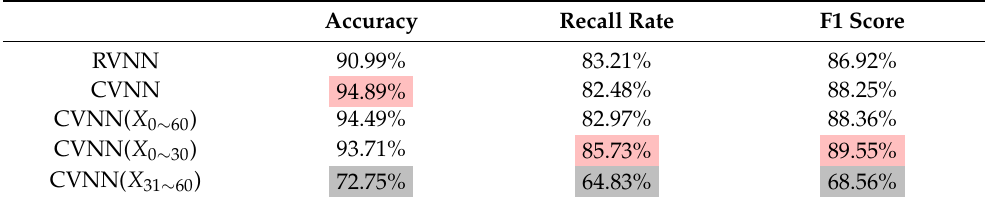
Figure 3. Comparison results between RVNN and CVNN as well as several variations for CVNN. X 0 ∼ 60 , X 0 ∼ 30 and X 31 ∼ 60 represent the only use of the first half, first quarter (low-frequency) and second quarter (high-frequency) of frequency components, respectively. Table 1. Quantitative comparison results between different models in terms of accuracy, recall rate and F1 score. The best and poorest performance for each metric is marked as pink and light gray signs,